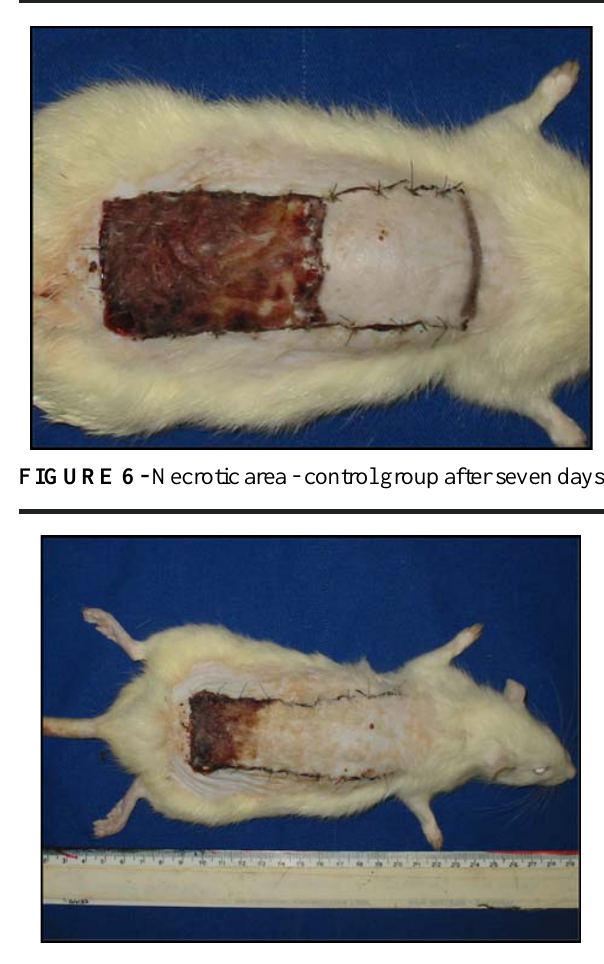
FIGURE 7 - Necrotic area - laser irradiation group after seven days of